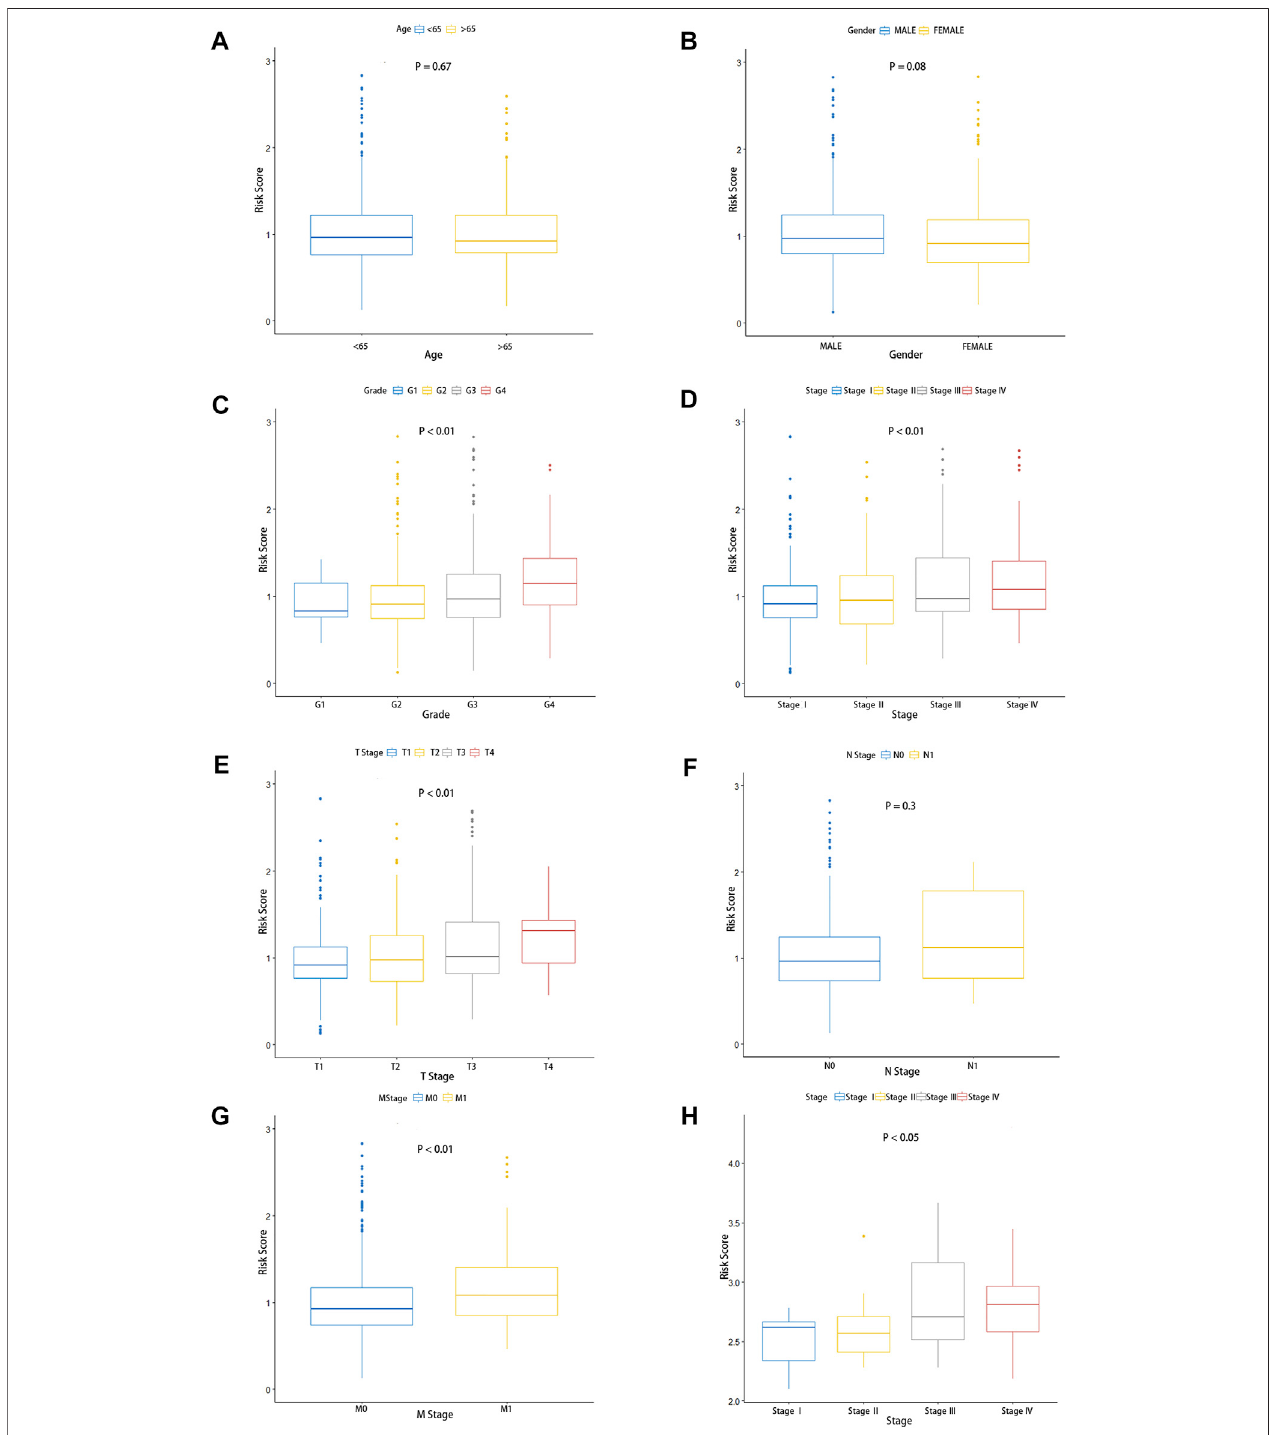
FIGURE 5 | Predictive value of fatty acid metabolism risk signature in the prognosis of patients with ccRCC. (A – G) Relationship between risk signature and clinical features,includingage (A) ,gender (B) ,pathologicalgrade (C) ,pathologicalstage (D) ,tumorsize (E) ,lymphoidinvasion (F) ,anddistalmetastasis. (G,H) Validationofthe association between the risk scores and pathological stage in the GEO database.